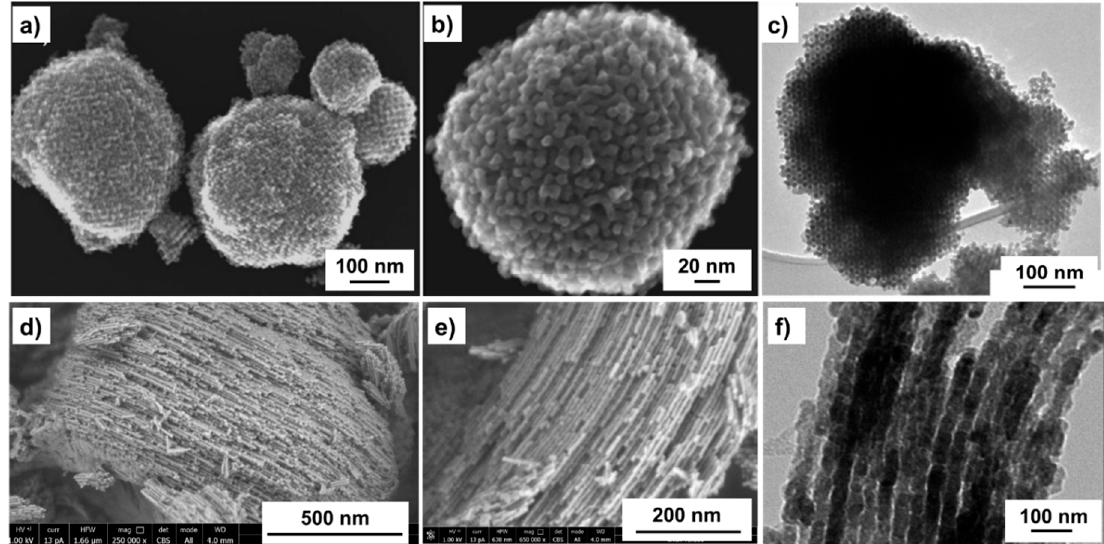
Figure 3. Scanning electron microscopy (SEM) and transmission electron microscopy (TEM) images of mCo 3 O 4 nanocasts from KIT-6 ( a , b , c ) and SBA-15 ( d , e , f ) ordered mesoporous silica materials. Images a , b , c [39] and d [34] were reprinted with a permission of © 2014 American Chemical Society.